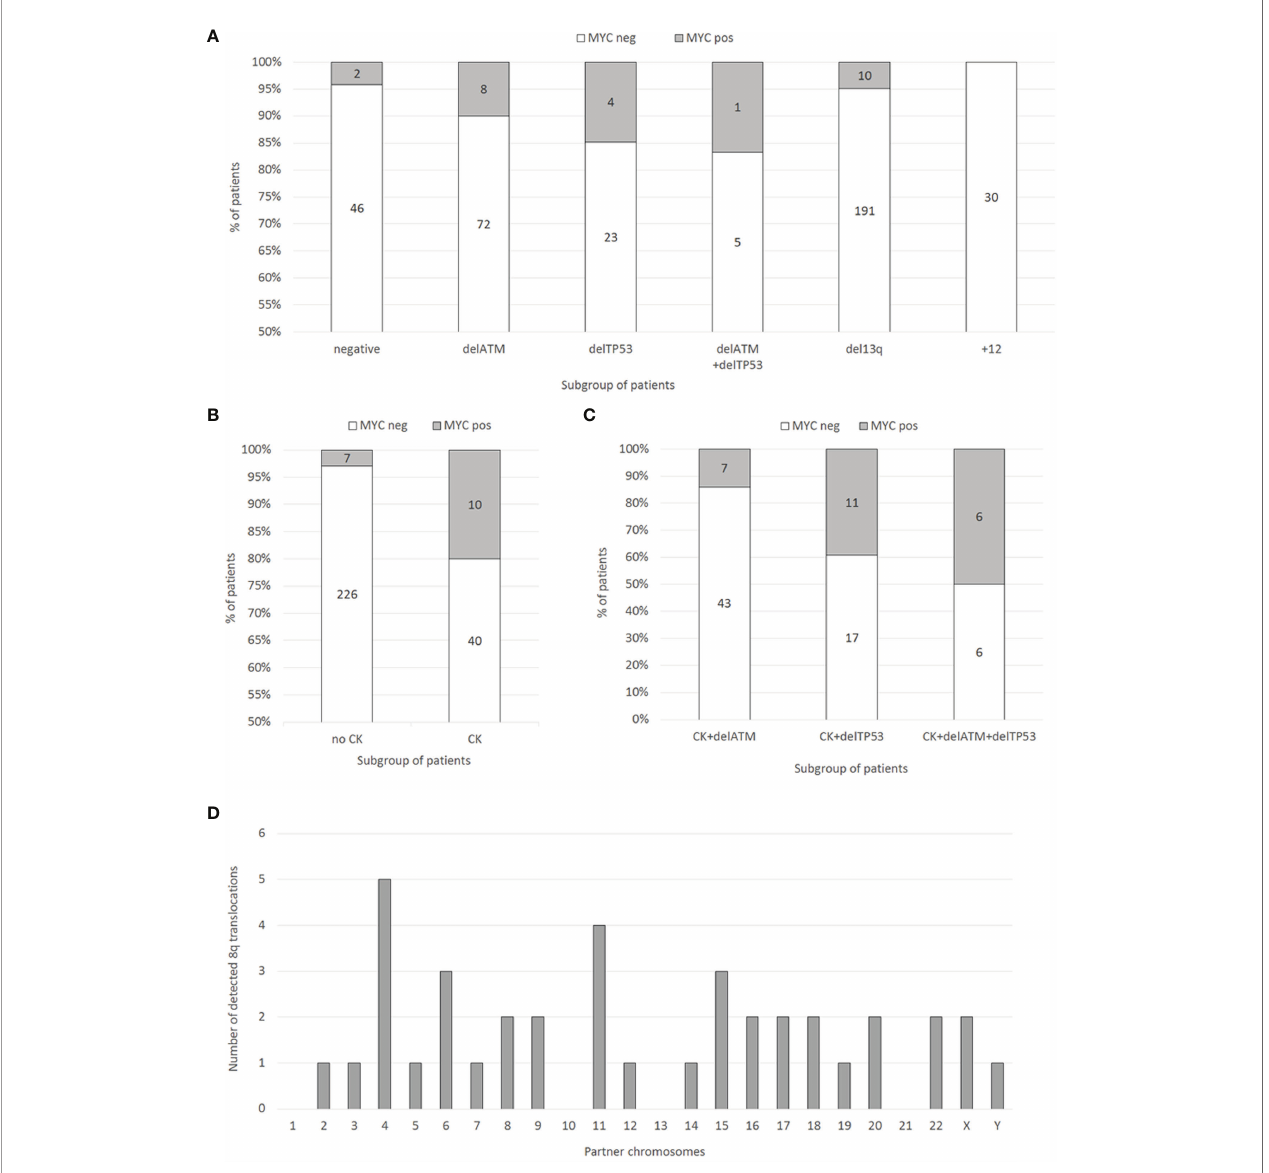
FIGURE 1 | (A) Distribution of MYC gains in the groups of patients with recurrent aberrations (del ATM , del TP53 , del(13q), +12, or negative) determined by FISH in 303 consecutive CLL patient samples. Numbers within columns represent absolute numbers of patients. (B) Distribution of MYC gains (determined by FISH) in the groups of patients with or without CK (determined by conventional chromosome banding) in 283 consecutive CLL patient samples. Numbers within columns represent absolute numbers of patients. (C) Distribution of MYC aberrations (determined by FISH) in 90 patient samples selected for the presence of CK (determined by conventional chromosome banding) together with either del TP53 or del ATM , or both (determined by FISH). Numbers within columns represent absolute numbers of patients. (D) The frequency and localization of the duplicated 8q region on individual chromosomes identi fi ed by the M-FISH